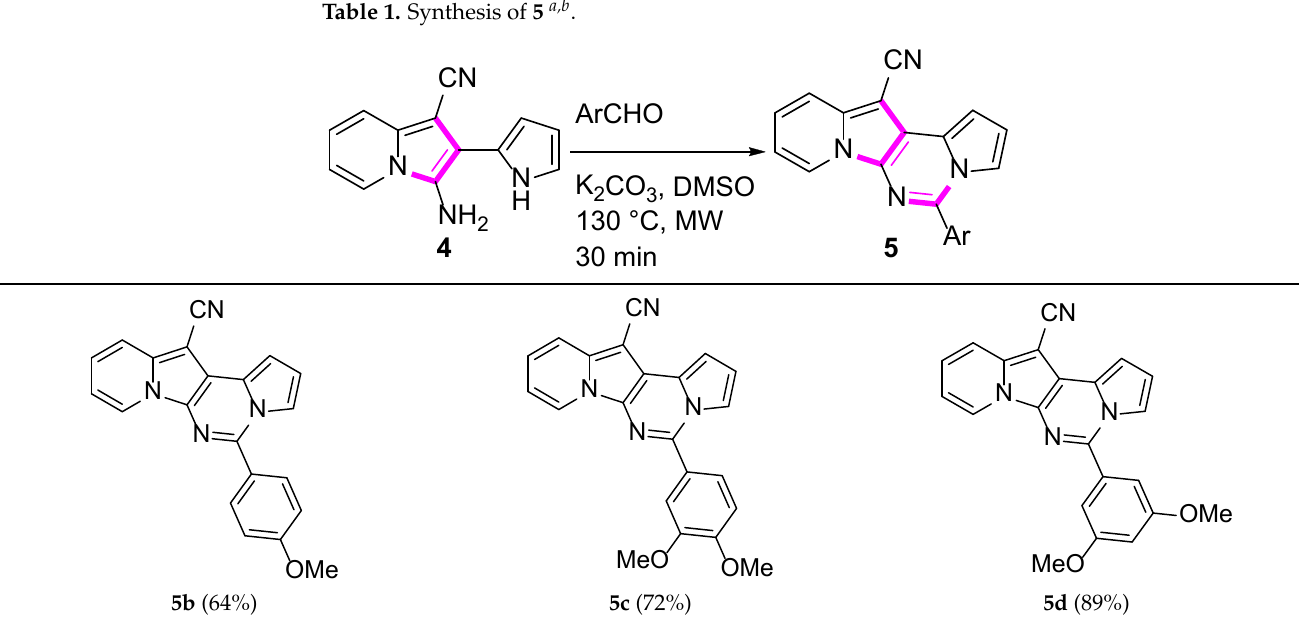
Table 1. Synthesis of 5 a,b .